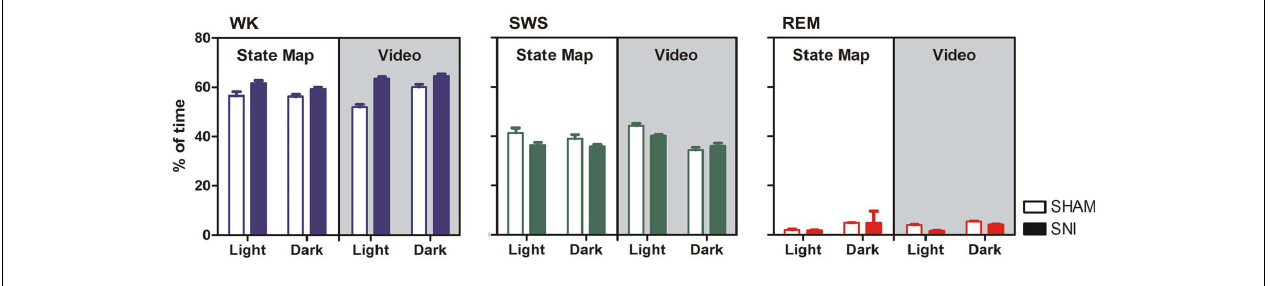
waking state (WK, blue), slow-wave-sleep (SWS, green), and rapid-eye-movement (REM, red). No statistical differences were encountered between both methodologies of detection (Mann–Whitney test, P < 0.05).The determinations are expressed for all animals as mean ( ± SEM).